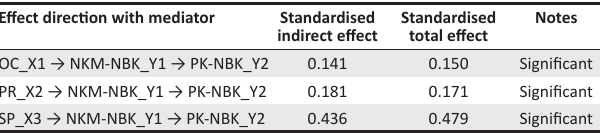
TABLE 4: Indirect effect and total